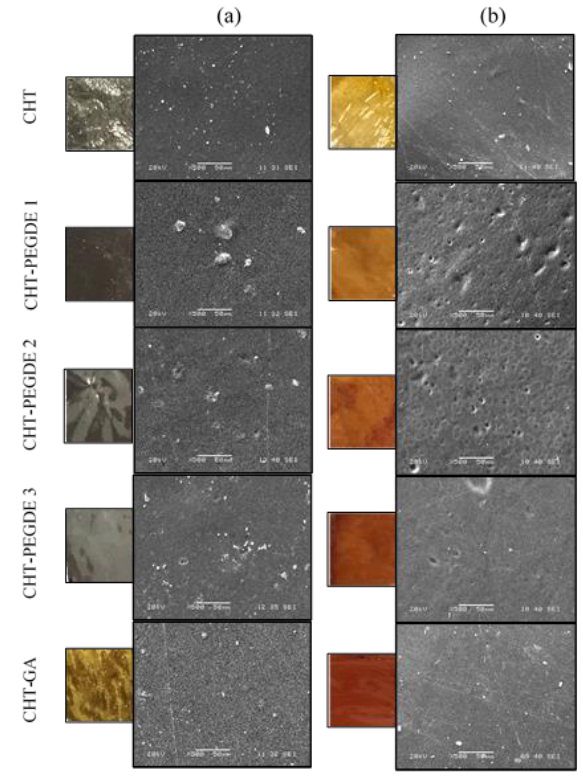
Figure 5. SEM surface morphology of CHT films dried at 25 °C ( a ) and 150 °C ( b ).